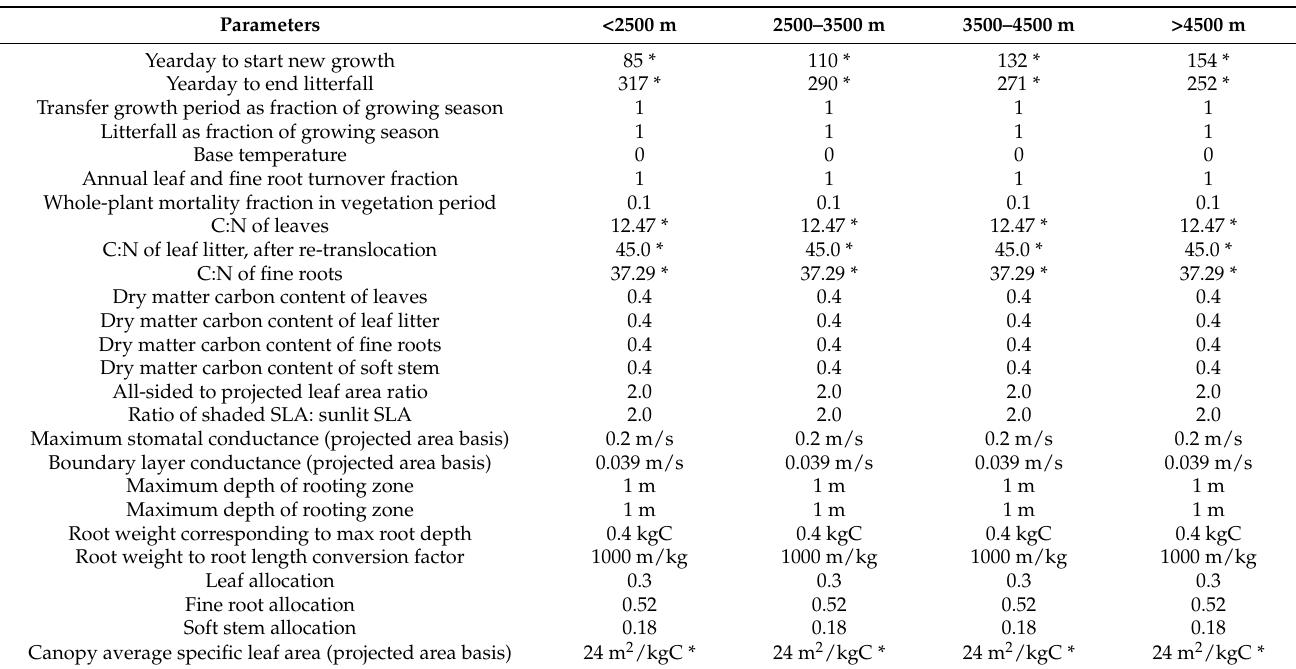
Table A1. The required physiological and ecological parameters.